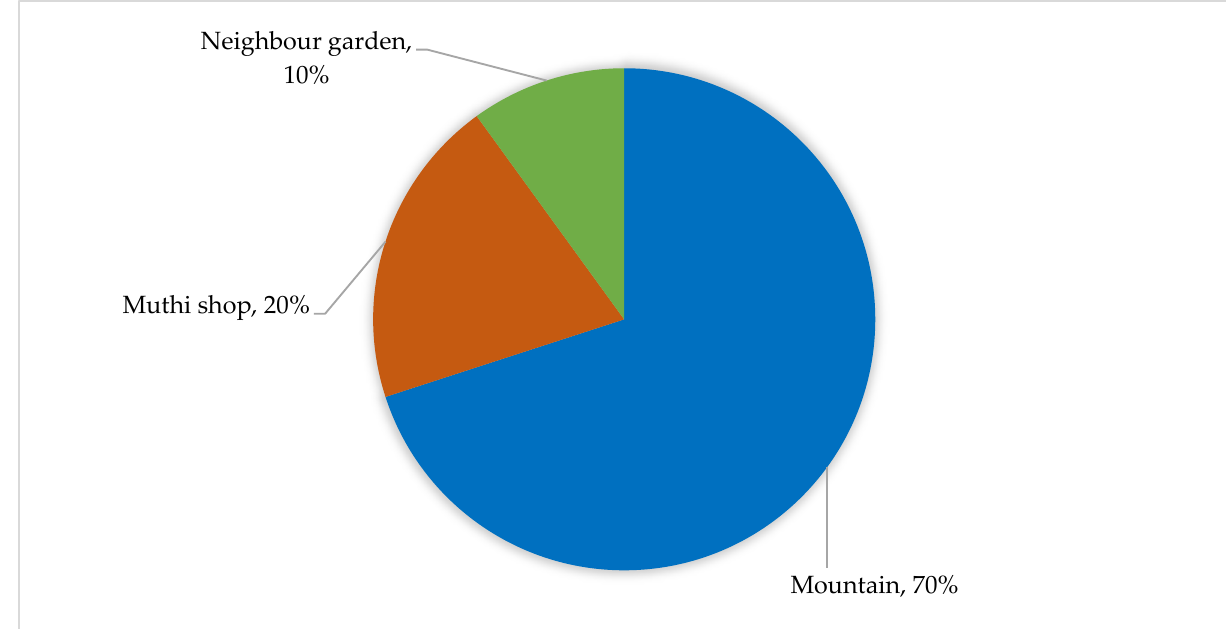
Figure 5. Distribution (%) source of African ginger for cultivation by the participants.